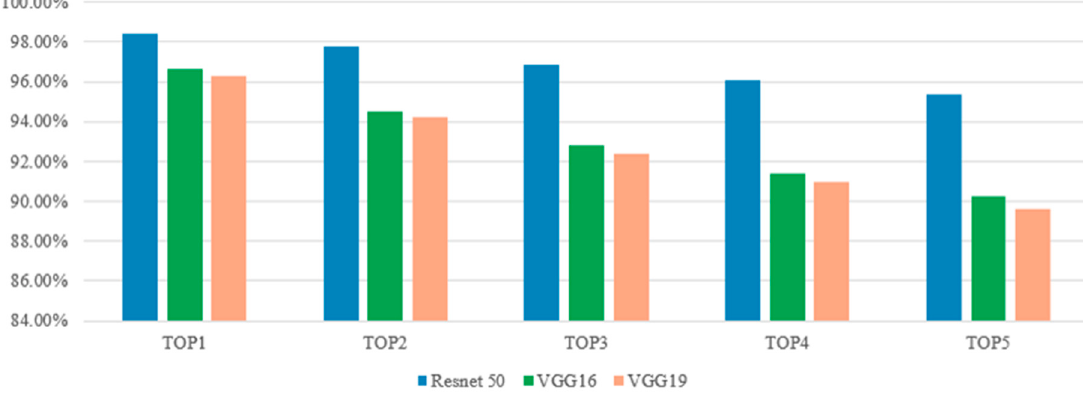
Table 5. Accuracy comparison between convolutional neural network (CNN) model and proposed method.